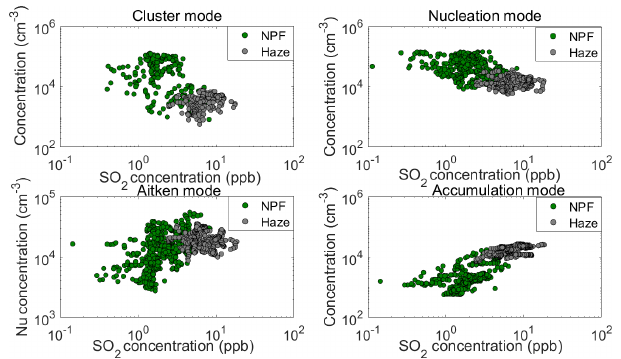
Figure 10. Correlation between the NO x concentration and particle number concentration in each mode. The time resolution of the data points was